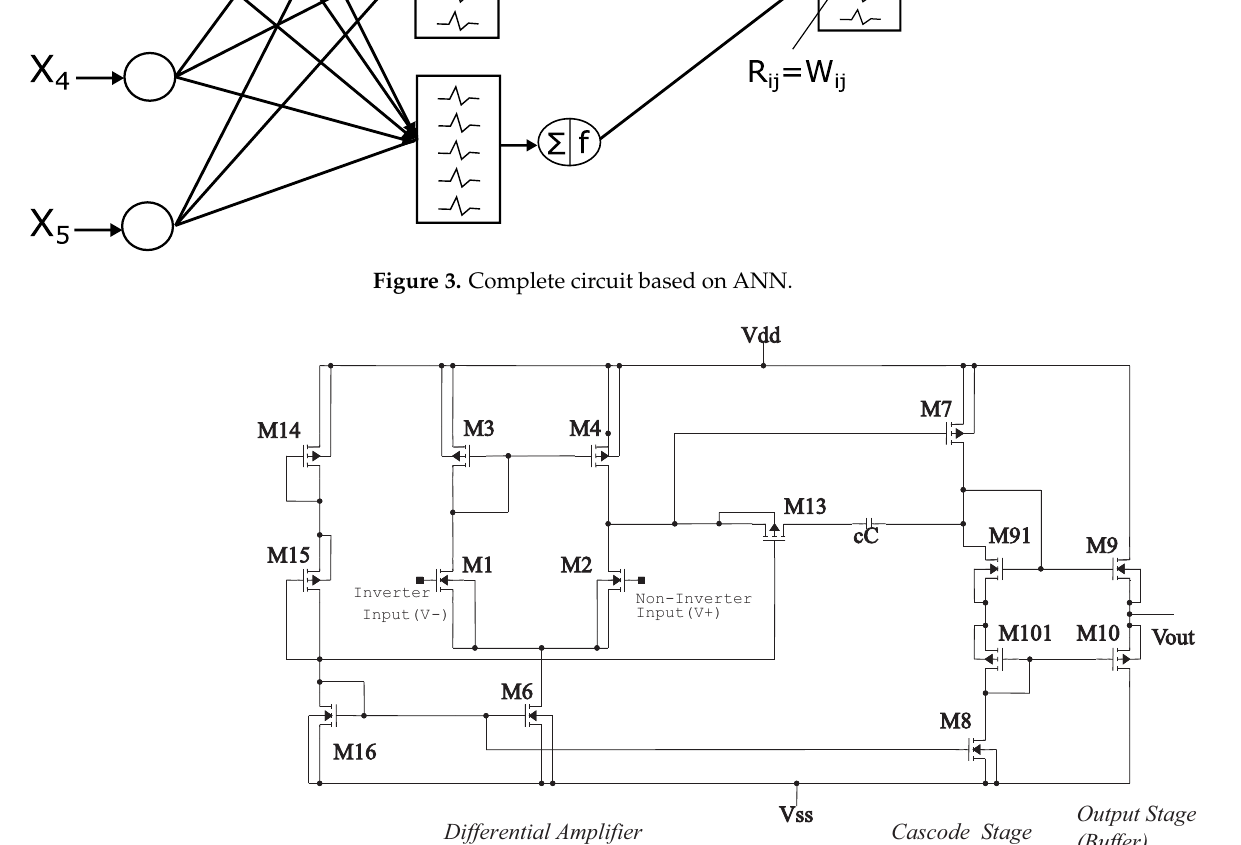
Figure 4. Operational amplifier 1.2 µ